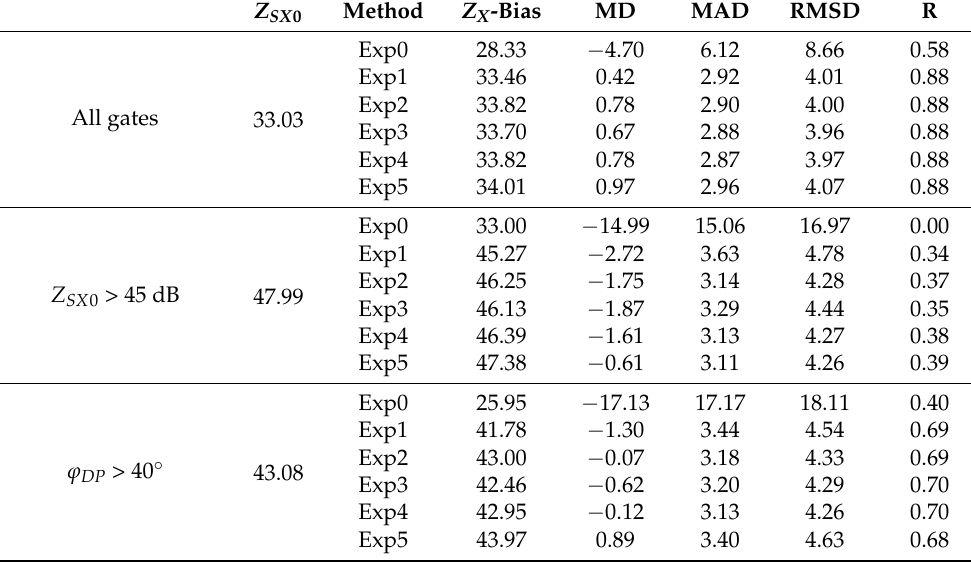
Table 5. Statistical analysis of X-PAR2 errors before and after attenuation